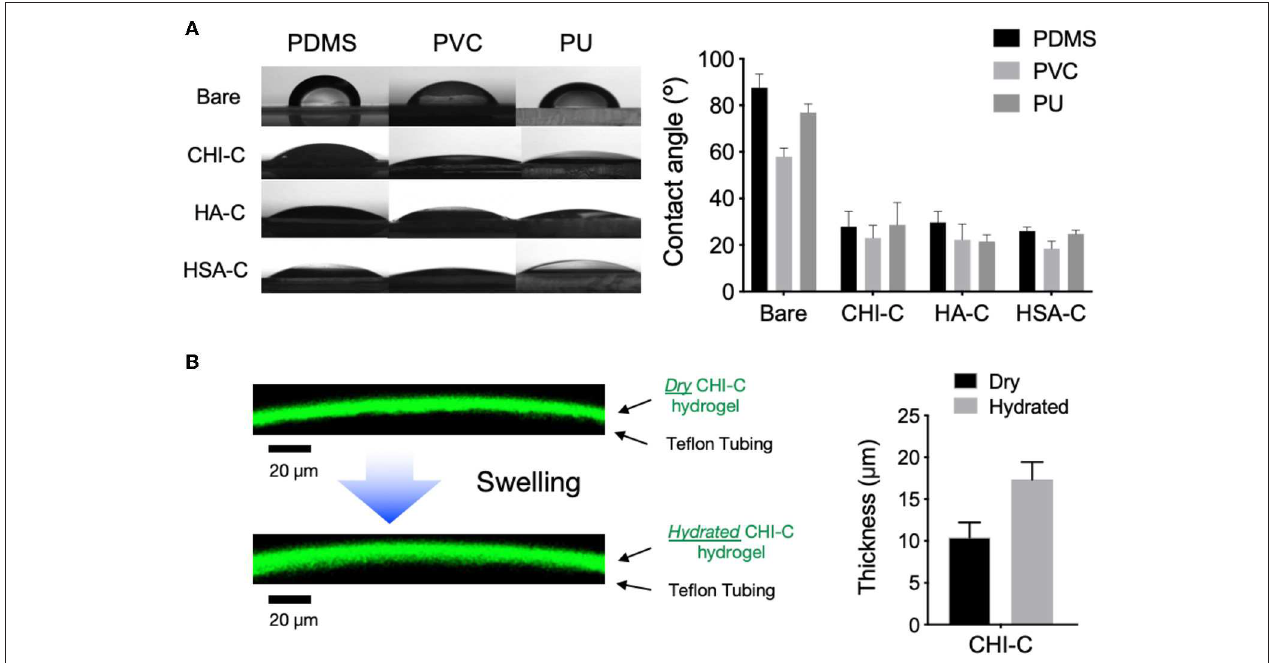
FIGURE 3 | Wettability of PDMS, PVC, and PU substrates with polymeric hydrogel coatings after 6 deposition cycles. (A) Measurement of water contact angles of substrates coated with hydrogel ( n = 3). (B) The side view of dry and water swollen FITC-conjugated CHI-C hydrogel coating on PTFE tube imaged with confocal microscope before and after immersion in PBS buffer (pH 7.4) for 10min (scale bar = 20 µ m) and the thickness of the CHI-C hydrogel coating.